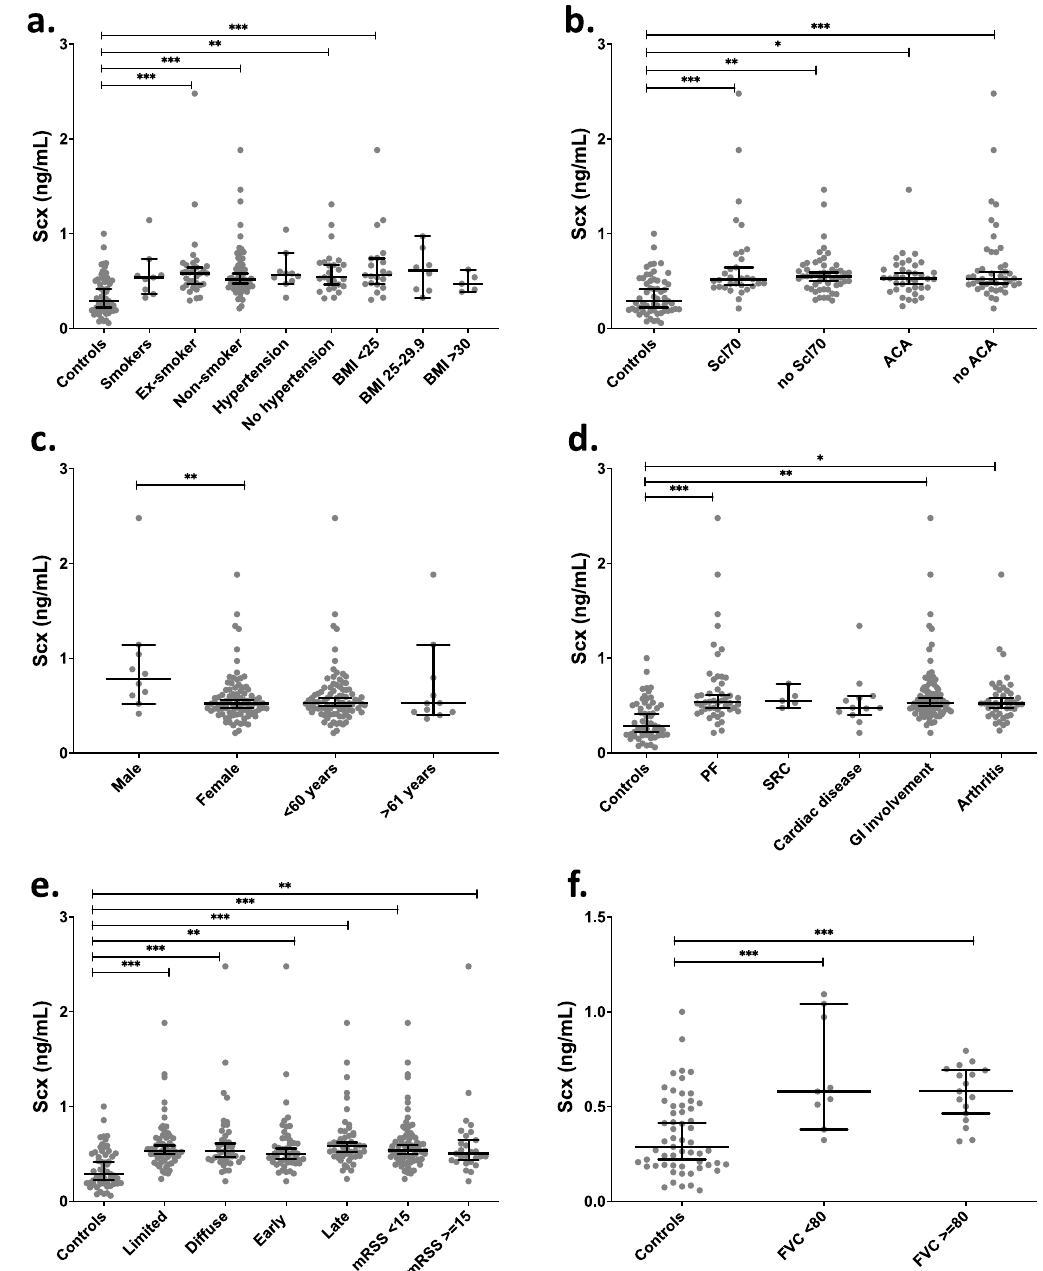
Figure 6. SCX serum levels were high in late progression SSc patients and patients su ff ering associated pulmonary fibrosis. SCX circulating levels were grouped by ( a ) smoking habit and BMI, ( b ) serologic profile, ( c ) sex and age, ( d ) internal organ involvement, ( e ) classification and progression, and ( f ) FVC. Supplementary file 2 includes an excel file with raw data. Secondary organ involvement comprised pulmonary fibrosis (PF), scleroderma renal crisis (SCR), and gastrointestinal involvement (GI). The GI included esophageal dysmotility, esophageal stricture, small bowel hypomotility or dilation, small bowel bacterial overgrowth, malabsorption syndrome, or use of parenteral nutrition. (d) SSc classification and progression. * = p < 0.05. ** = p < 0.01. *** = p < 0.001. Scl70 = anti-topoisomerase I antibodies.